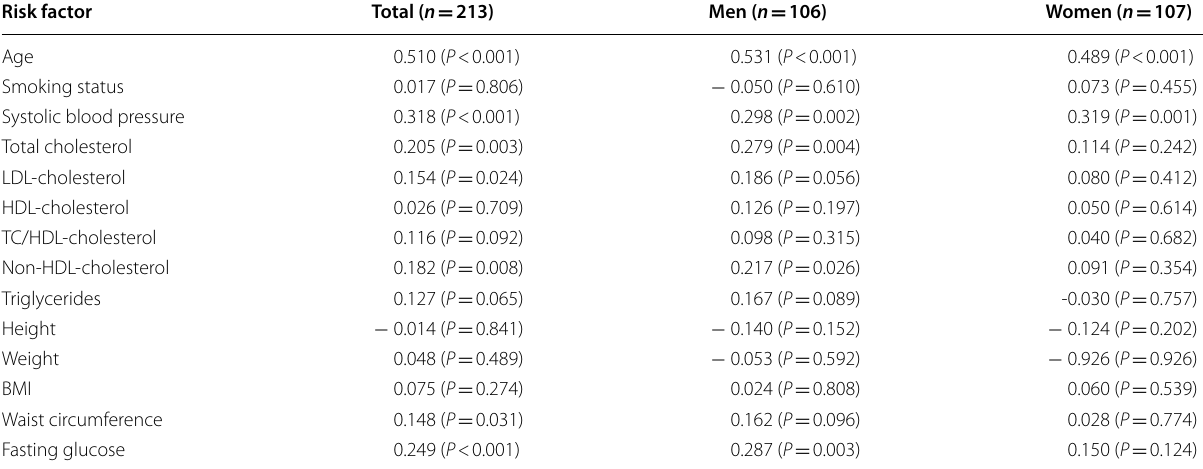
Table 3 Pearson correlation between single common cardiovascular risk factors and carotid intima–media thickness in men and women